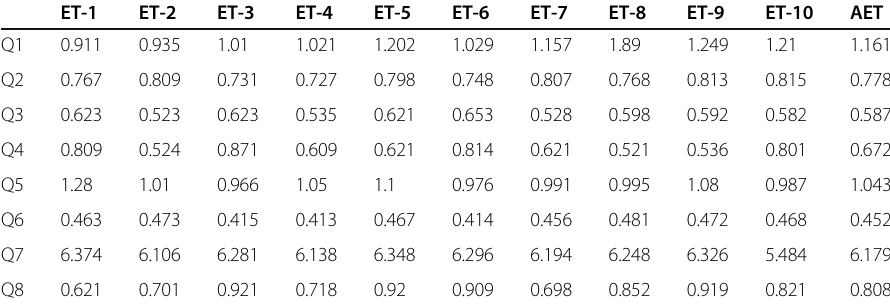
Table 13 Query execution time for Amazon EKS with Washington State data for